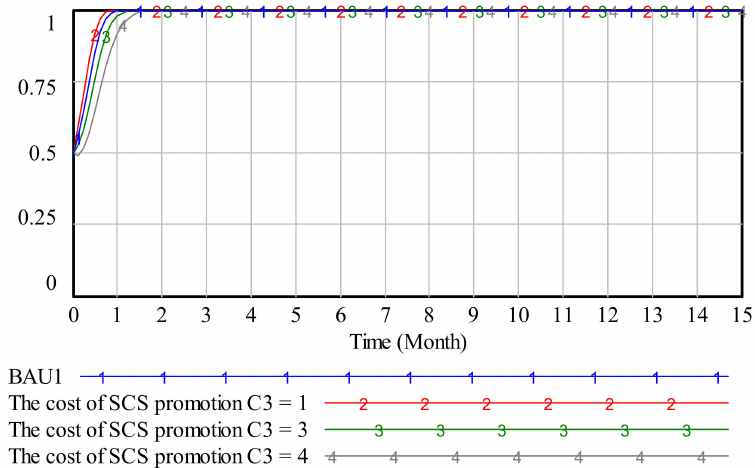
Figure 14. Impact of C 3 on project strategy selection in the BAU1 scenario.